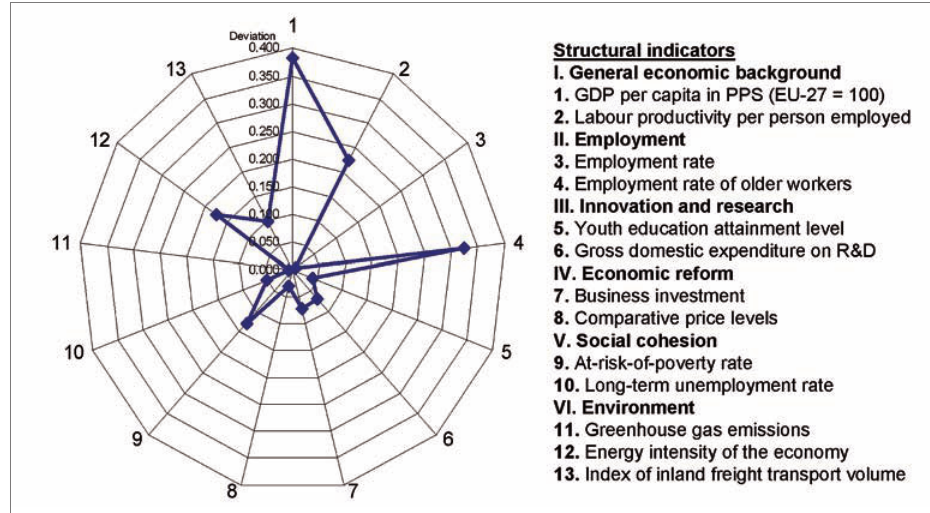
Fig. 5. Deviations of Lithuania’s structural indicators values from maxima in the European Union (Reference point approach),